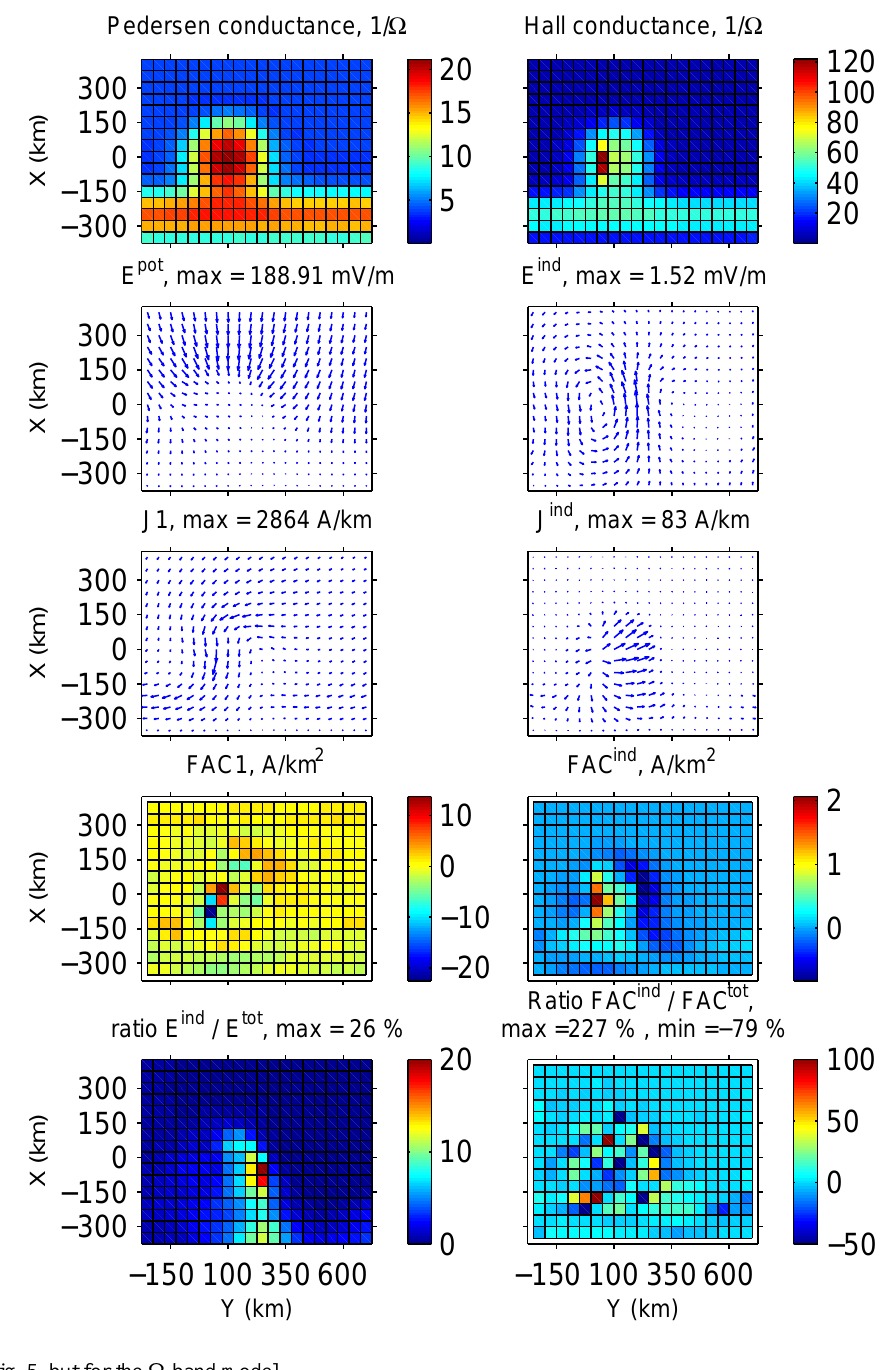
Fig. 13. Same as Fig. 5, but for the (cid:127) -band model.